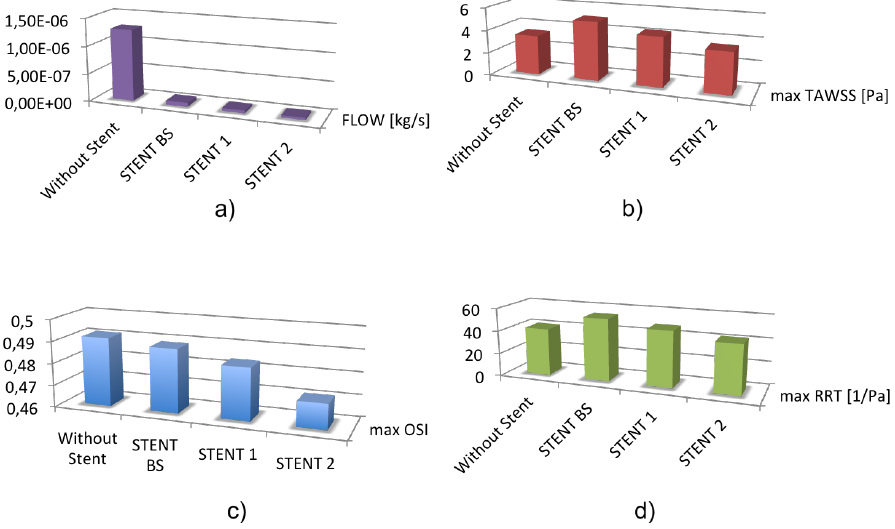
Figure 7. ( a ) Flow reduction promoted by FDSs, ( b ) peak TAWSS, ( c ) OSI, and ( d ) RRT ( d ) in the aneurysmatic sac for the artery without treatment and in the presence of the three considered